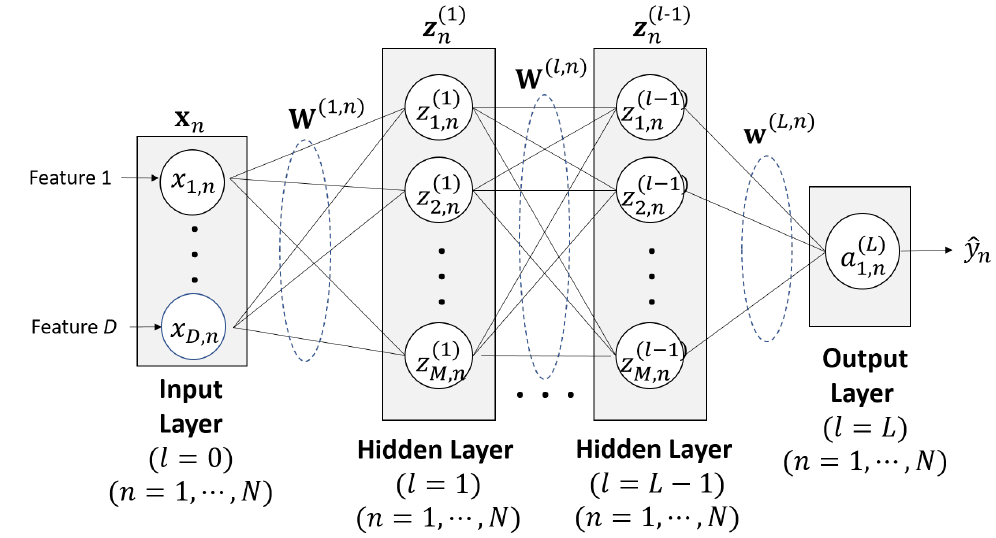
Figure 5. Block diagram of ANN-MLP with D